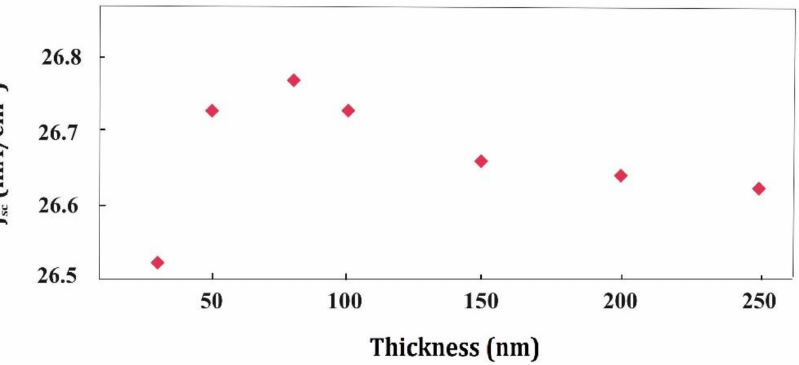
Figure 2. The short circuit current density (in mA/cm 2 ) of the InP NW array solar cell for varying thickness of Au layer for the fixed radius of 100 nm and pitch of 500 nm.